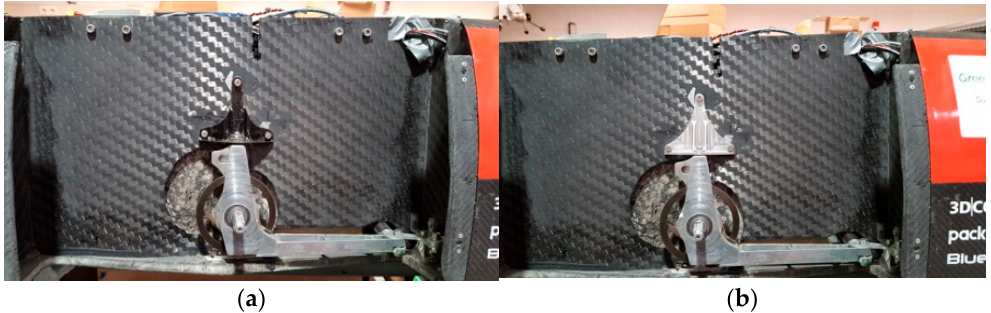
Figure 22. Component mounted in the prototype: ( a ) new BFRP component. ( b ) Original alumi- num component.